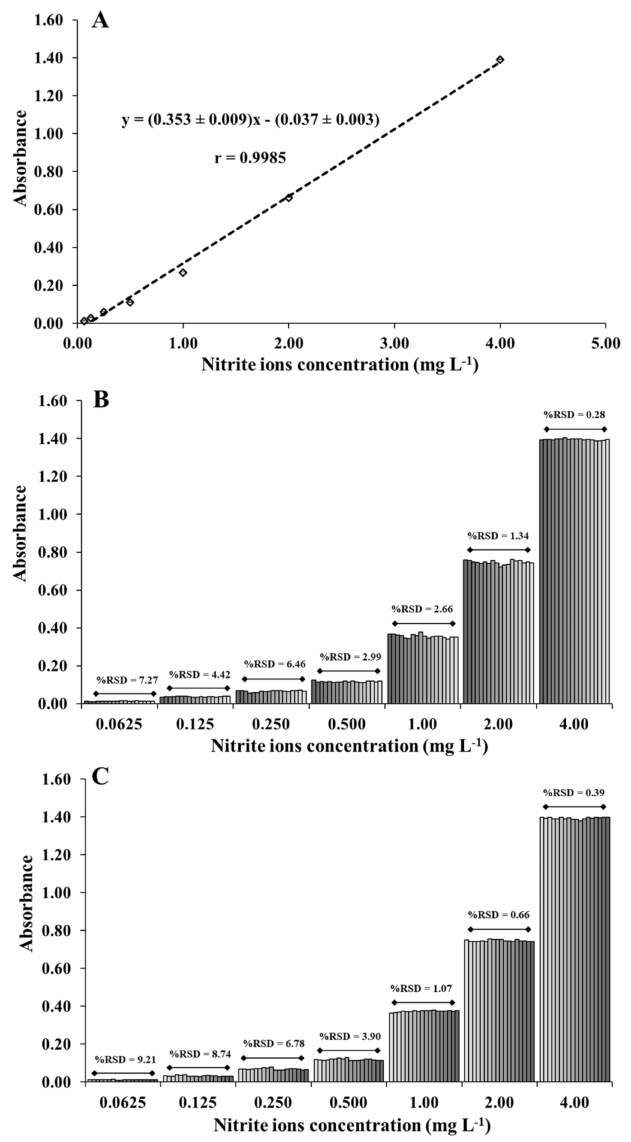
Figure 4. ( A ) The calibration plot between absorbance and concentration of nitrite ions. The repeata- bility of ( B ) intra-day and ( C ) inter-day